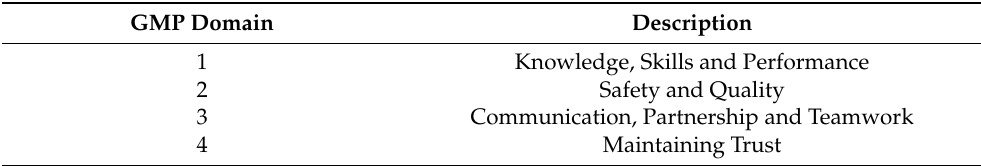
Table 1. Description of Good Medical Practice (GMP) Domains